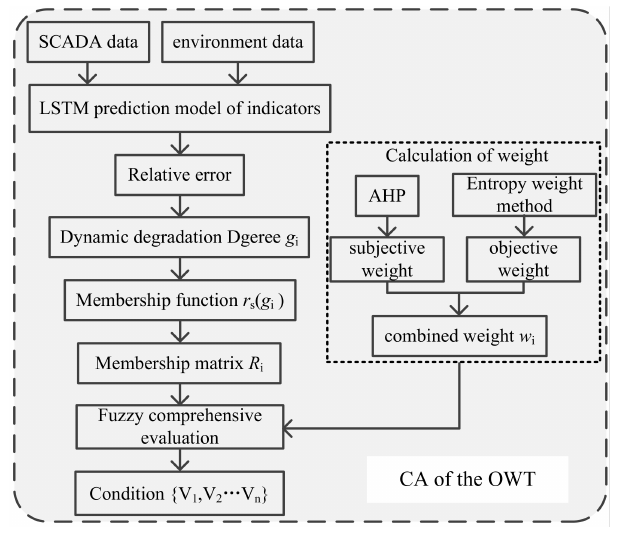
Figure 2. Process of CA of the